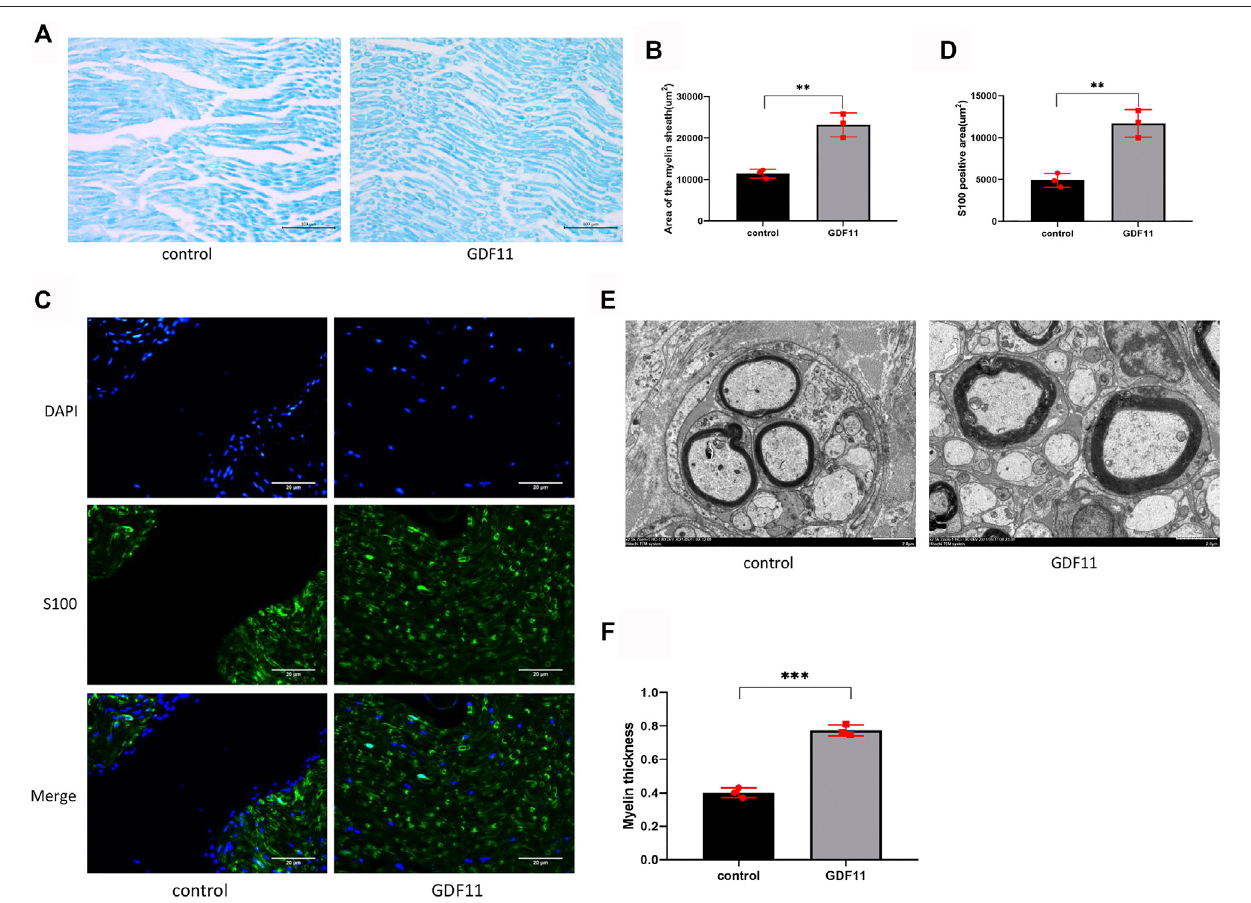
FIGURE6| GDF11promotesmyelinregenerationofdamagedsciaticnerveinrats. (AandB). At3monthspostoperatively,myelinstainingwasusedtoassessthe extentofmyelinationintheinjuredsciaticnerveareainrats(n (cid:1) 3). (CandD). Threemonthsaftersurgery,S100waslabeled withSchwanncellstodetectSchwanncells inthedamagedarea(n (cid:1) 3). (EandF). Threemonthsaftersurgery,atransmissionelectronmicroscopewasperformedonthesciaticnerveintheinjuredareaofrats,and myelin sheath thickness and neovascularization were assessed (n (cid:1) 3). Statistical analysis was based on at least three different biological samples and three technical replicates, p < 0.05 was considered to be statistically signiand fi lig;cant. Representative images are